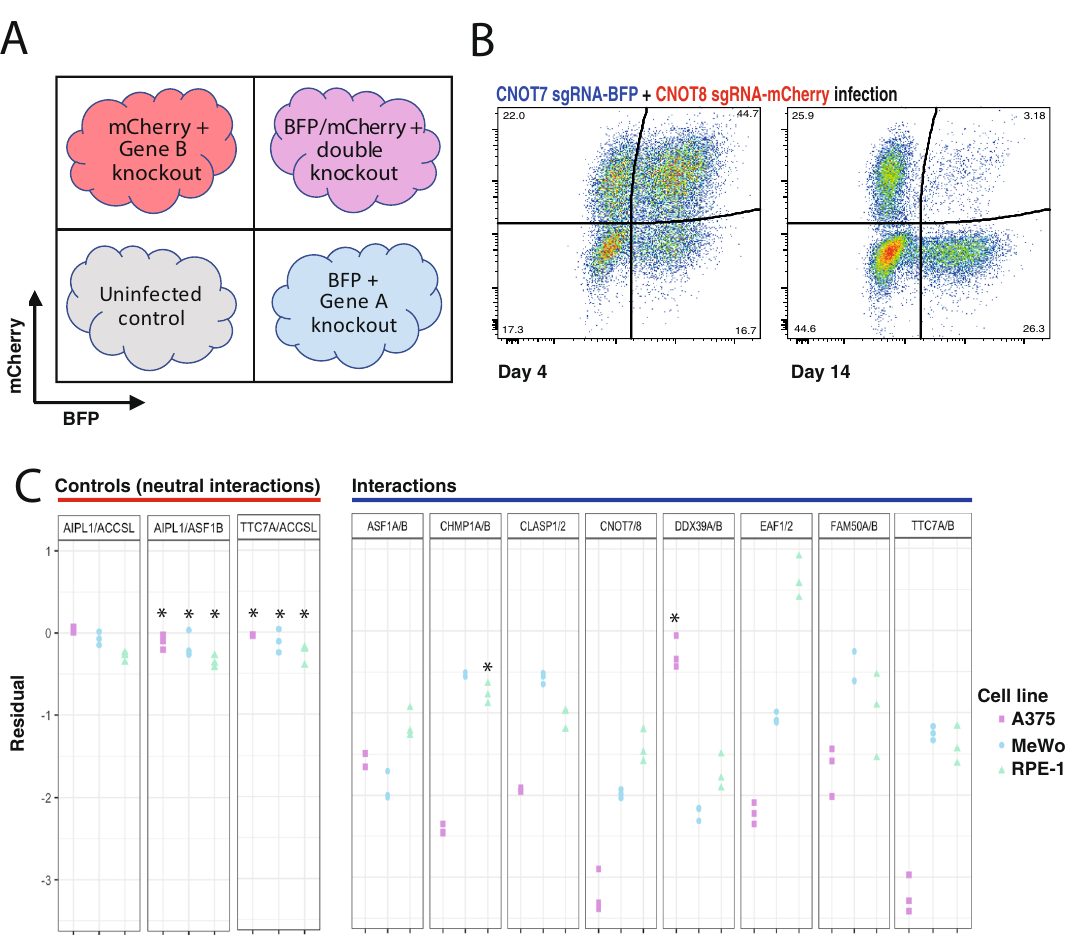
Fig. 2 Validation of candidate synthetic lethal pairs. A Schematic of the competitive growth assay. Cas9-expressing cells were infected with lentiviruses expressing each gRNA in a BFP or mCherry vector to create four populations and read by FACS at day 4 and 14. B Example of a synthetic lethal pair. A375- Cas9 cells were transduced with lentiviruses expressing CNOT7 (BFP) and CNOT8 (mCherry) sgRNAs and analysed at two timepoints. The growth phenotype was calculated by measuring the relative depletion of the single-infected and double-infected cells. C Residual values from competitive growth experiments. Residuals were calculated as the difference between the expected phenotype of the double-positive population (based on summing the phenotypes of the single positive populations) and the observed phenotype of the double-positive population. Data represent three independent transductions. The baseline residual for three non-interacting-pairs (negative controls) are also shown ( AIPL1 & ACCSL , AIPL1 & ASF1B, TTC7A/ACCSL ). Residuals were compared with values for the control ACCSL/AIPL1 gene pair. Signi fi cance was calculated using a one-way ANOVA and adjusted for multiple testing using the Dunnett test. All interactions, except where indicated, had a P value <